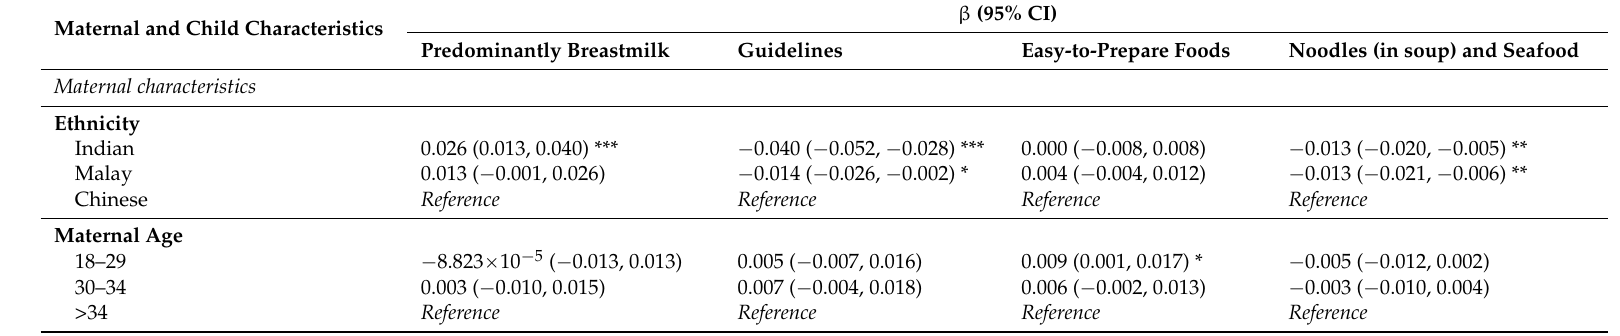
Table 2. Adjusted associations between dietary pattern trajectory slopes and sociodemographic characteristics ( n = 486) a . Maternal and Child